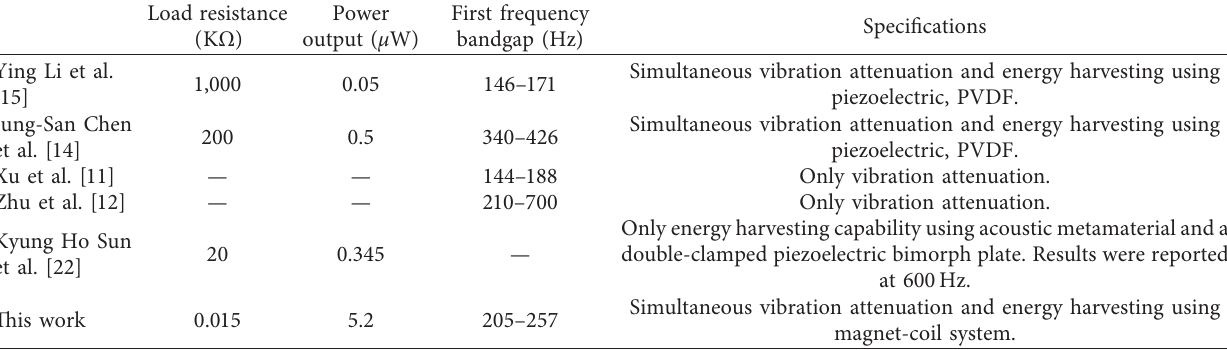
Figure 11: Measured output electric power spectrum from a single cantilever at fixed, optimum, load resistance of 15 Ω and acceleration level of 0.5g m.s − 2 . Measured frequency bandgap is denoted in red. Table 3: Comparison between the presented work and recent advancements in the